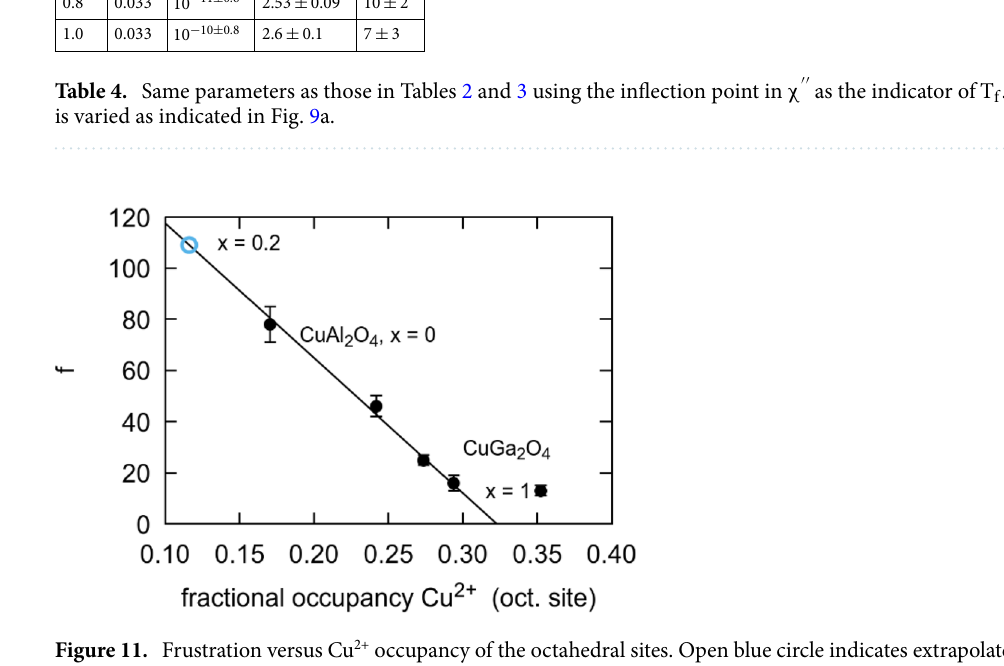
Figure 11. Frustration versus Cu 2+ occupancy of the octahedral sites. Open blue circle indicates extrapolated 0.2 value for x =